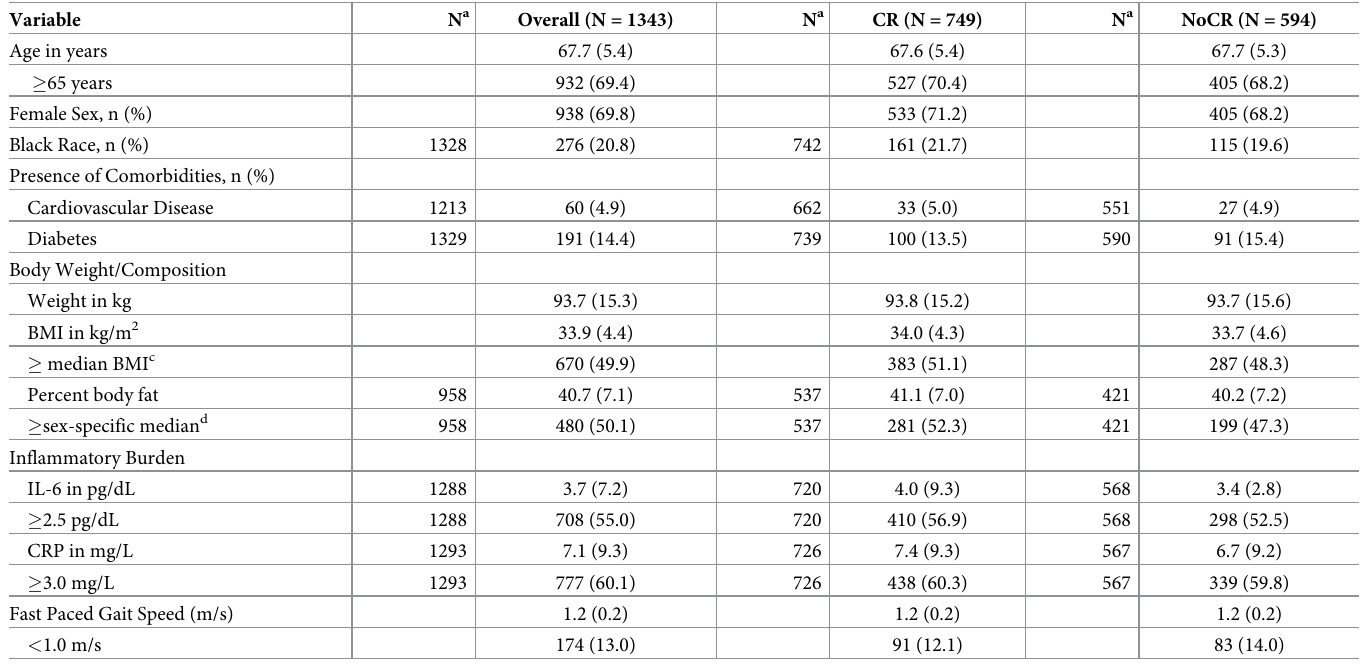
Table 2. Baseline characteristics of study sample, overall and by treatment